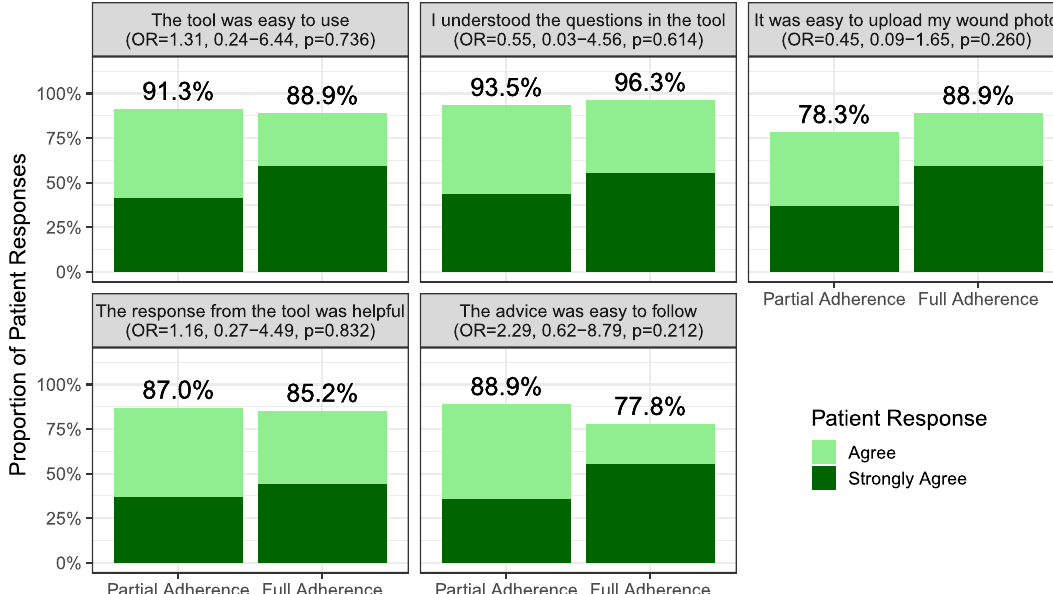
Fig. 4 Patient experience of those who used the smartphone tool. The fi ve measures of patient experience in patients who used the intervention ( a ) ease of tool use, ( b ) understandability of tool, ( c ) ease of image upload, ( d ) helpfulness of advice, and ( e ) Feasibility of advice. This has been strati fi ed by adherence: either full adherence (completion of all three routine response requests in the follow-up period) or partial use (any usage of the tool that did not meet the criteria of full adherence). These plots display the percentage (%) of patients who reported positive responses to these measures ( “ agree ” or “ strongly agree ” ) and provides an effect estimate (odds ratio [OR]) of the odds of positive response in patients who displayed full adherence, compared to partial